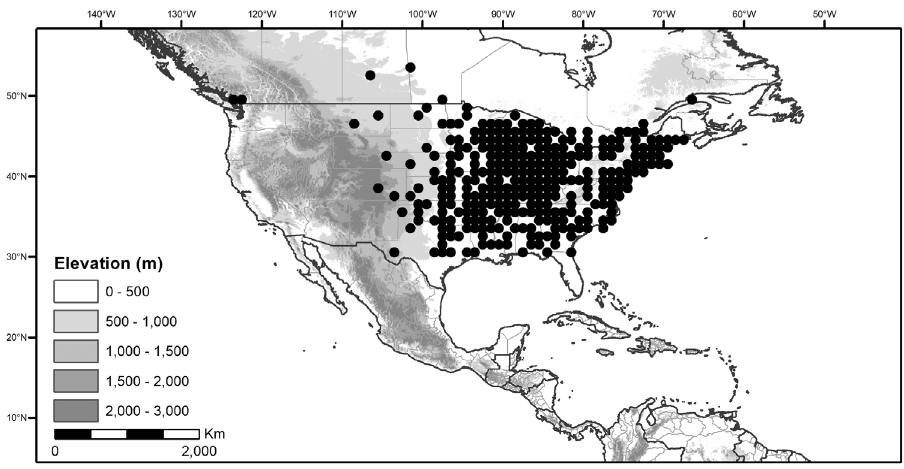
Figure 17. Distribution of Solanum emulans Raf. Common names. Canada. Eastern black nightshade, morelle noire de l’est (Bas- sett and Munro 1985, as S. ptychanthum ); crêve-chien; tue-chien (Québec, Marie-Vic- torin et al. 3942 ). United States of America. American black nightshade (USDA Plants 2017, as S. ptychanthum ), Eastern black nightshade (Ogg et al. 1981; Uva et al.